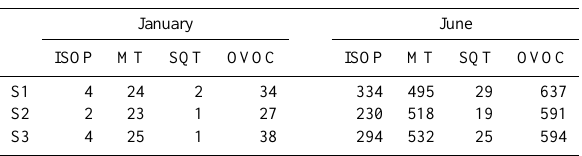
Table 6. Total emissions in Ggmo − 1 for January and June 2006 (common